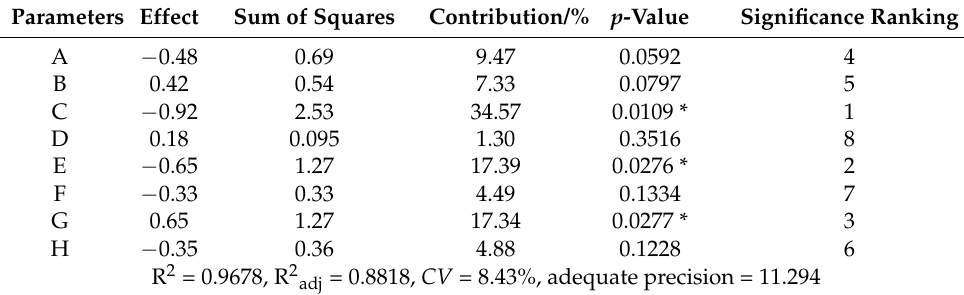
Table 4. Analysis of significance parameters in Plackett-Burman test.